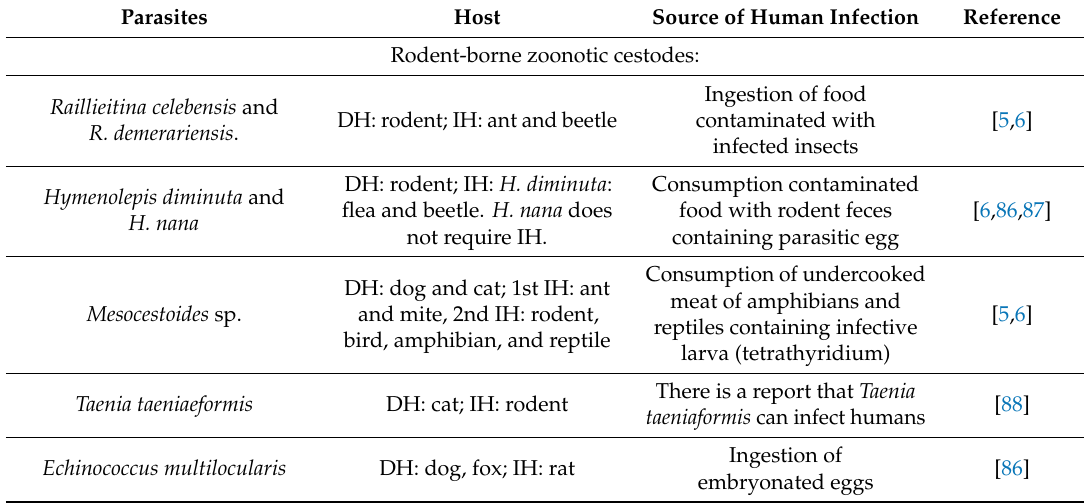
Table 2. Rodent-borne zoonotic helminths in the Middle East